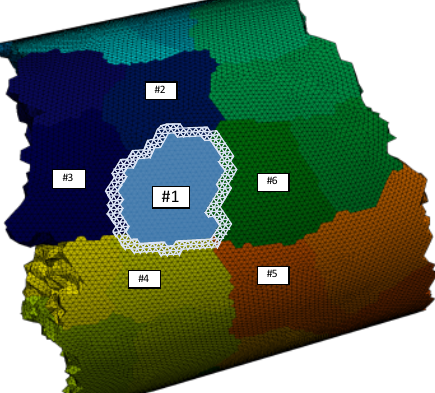
Figure 6. Ghost particle method principle shown for a part of a cylindrical domain. The different processor domains are colored accordingly. The processor of interest is ranked #1 ( ) and its closest neighbors are ranked #2, #3, #4, #5 and #6. A particle entering the white cell halo around #1 will be sent to #1 as a ghost particle by the processor it belongs